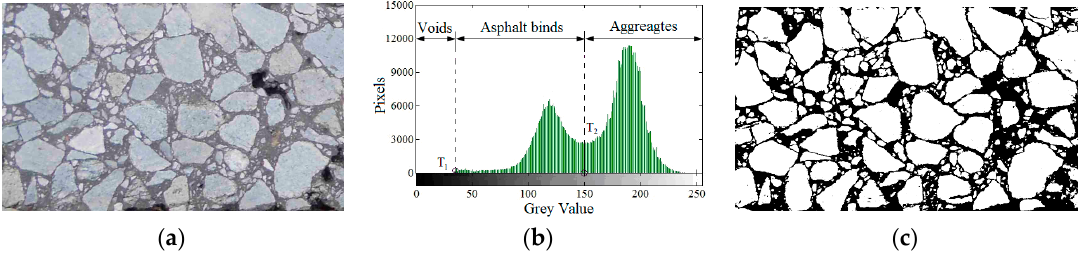
Figure 1. Image processing. ( a ) Original image; ( b ) grey histogram; and ( c ) binary image.